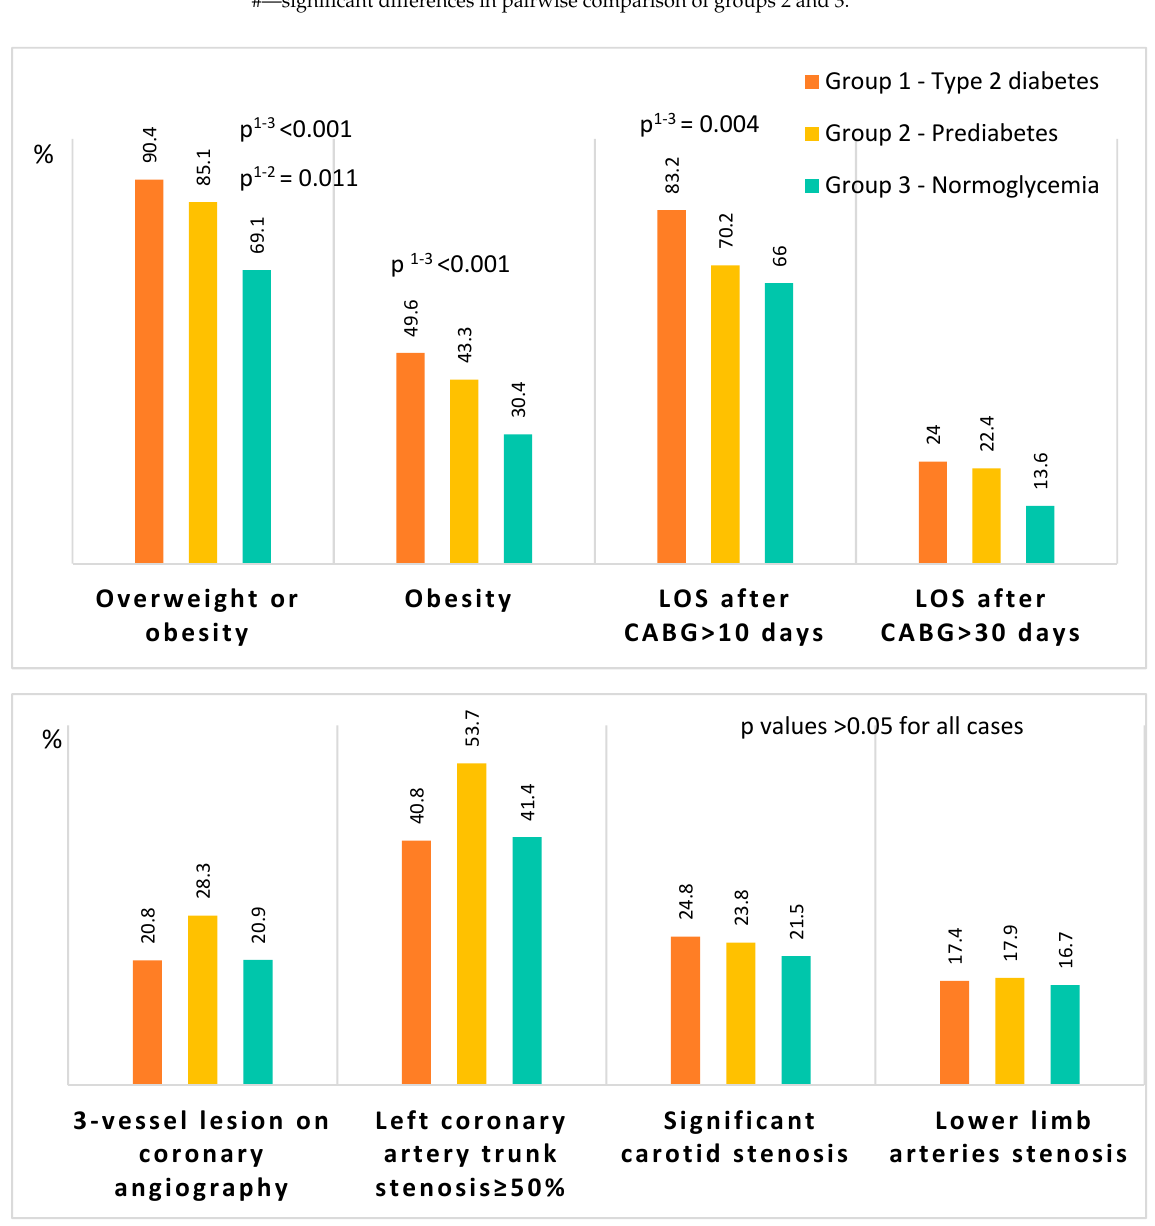
therapy, which was taken only by patients with DM (Table 1). In the DM group, 32.1% of patients took oral antihyperglycemic drugs before hospitalization and 15.2% received in- sulin. During hospitalization in preparation for CABG, 41.6% of patients with DM re- ceived insulin therapy (Table 1). Preoperative EuroSCORE II risk scores showed the low- est risk score among prediabetic individuals compared with the other two groups (Table 1). At the same time, medians of hospitalization of the DM and prediabetes groups were similar—13.0 days for the normoglycemia group—12.0 days ( p < 0.001). Overweightness or obesity was very common in this cohort, occurring in 90.4% of diabetic patients, 85.1% of pre-diabetic patients, and 69.1% of the normoglycemic group.